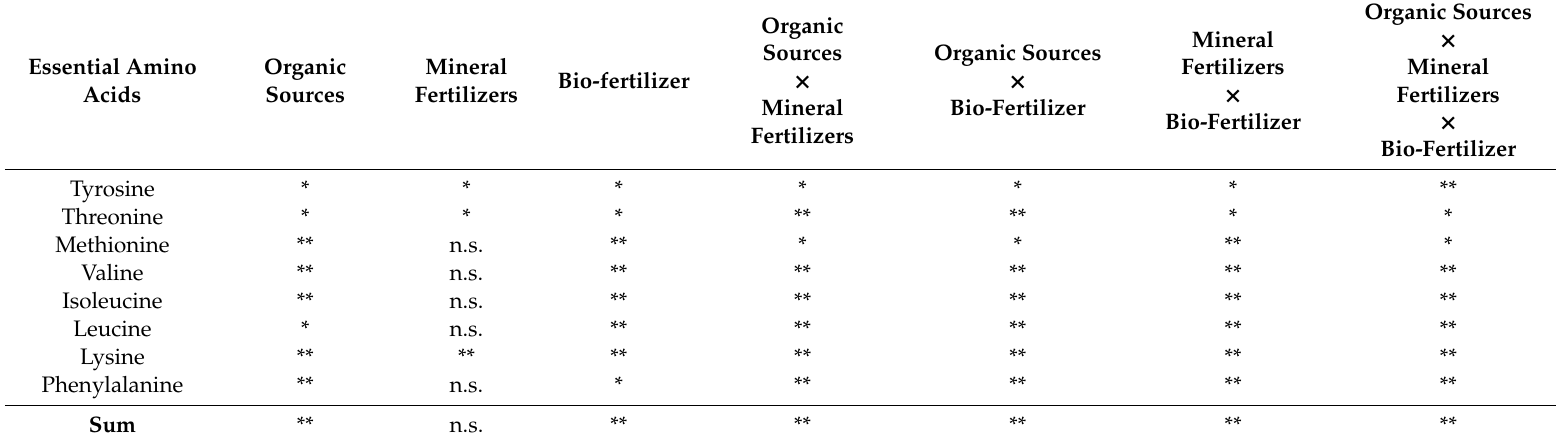
Table 5. Essential amino acids content. Significance of experimental factors and their interaction, mean for three years of study.